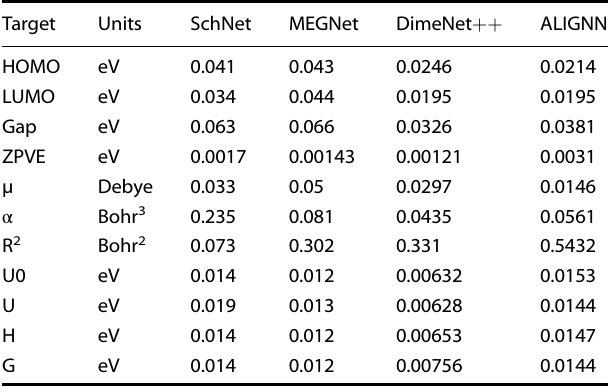
Table 5. Regression model performances on QM9 dataset for 11 properties using ALIGNN.